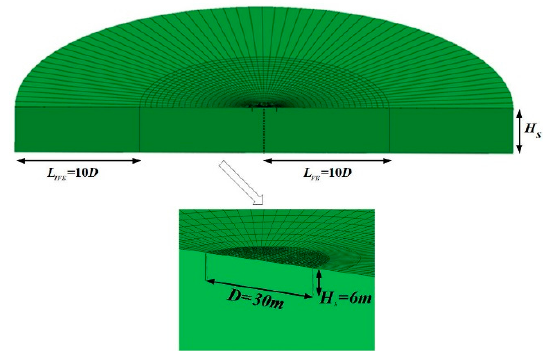
Figure 6. The finite-infinite element (FE-IFE) model of WSBF.